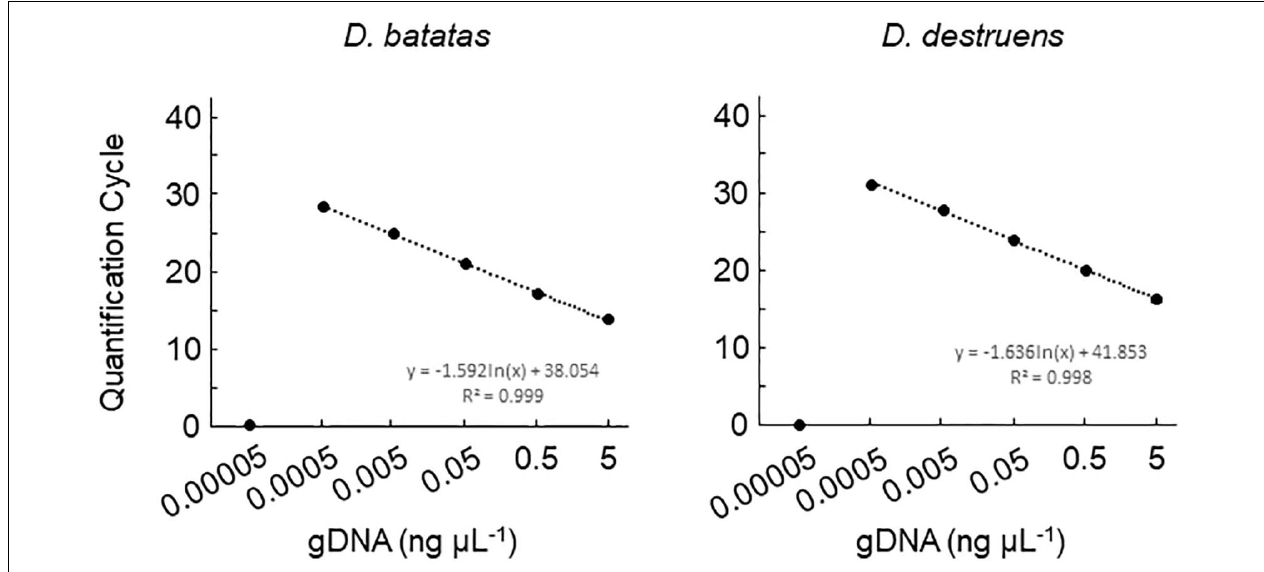
FIGURE 2 | Amplification of Diaporthe batatas and Diaporthe destruens DNA by real-time PCR with Db ITS and Dd ITS primers. Template DNA was prepared from conidial samples separately from D. batatas strain MOKM-3S-B and D. destruen s strain KTJ-1R-a, and were used to prepare 10-fold DNA dilution series of DNA (5.0, 0.5, 0.05, 0.005, 0.0005, and 0.00005 ng µ L − 1 ). Three biological replicates of each dilution were prepared. The regression equations and R 2 coefficient of determination for Cq value versus the natural logarithm of concentration of amplified gDNA are shown on the chart. Data represent means ± standard deviation where